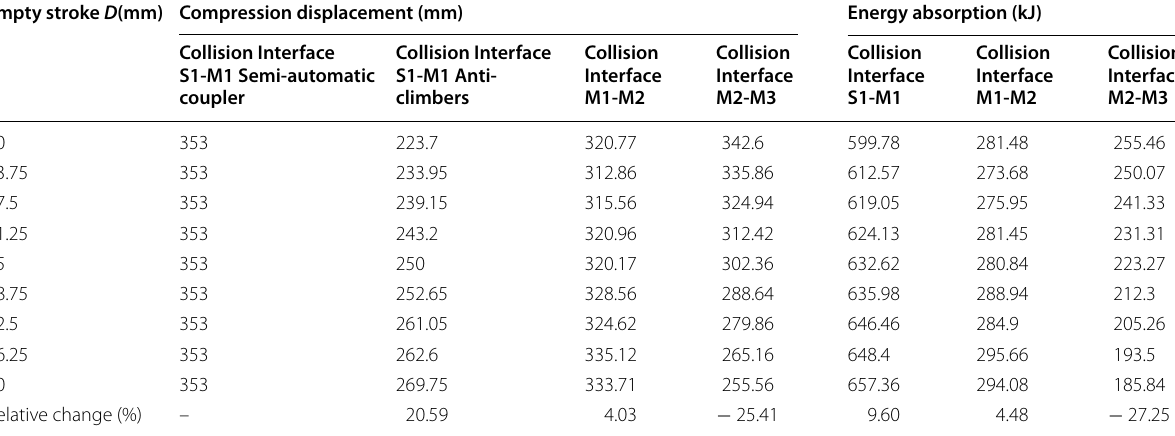
Table 3 Collision responses of the energy-absorbing devices under different empty stroke D Empty stroke D (mm) Compression displacement